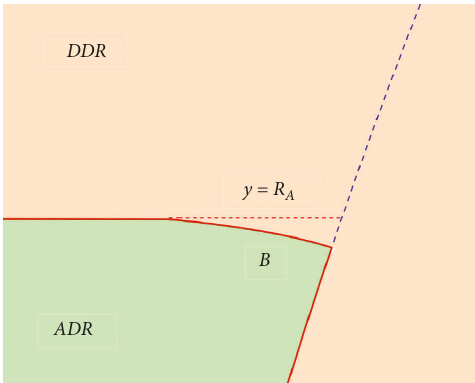
Figure 11: The local enlarged figure of the part of Figure 10 surrounded by the black box.